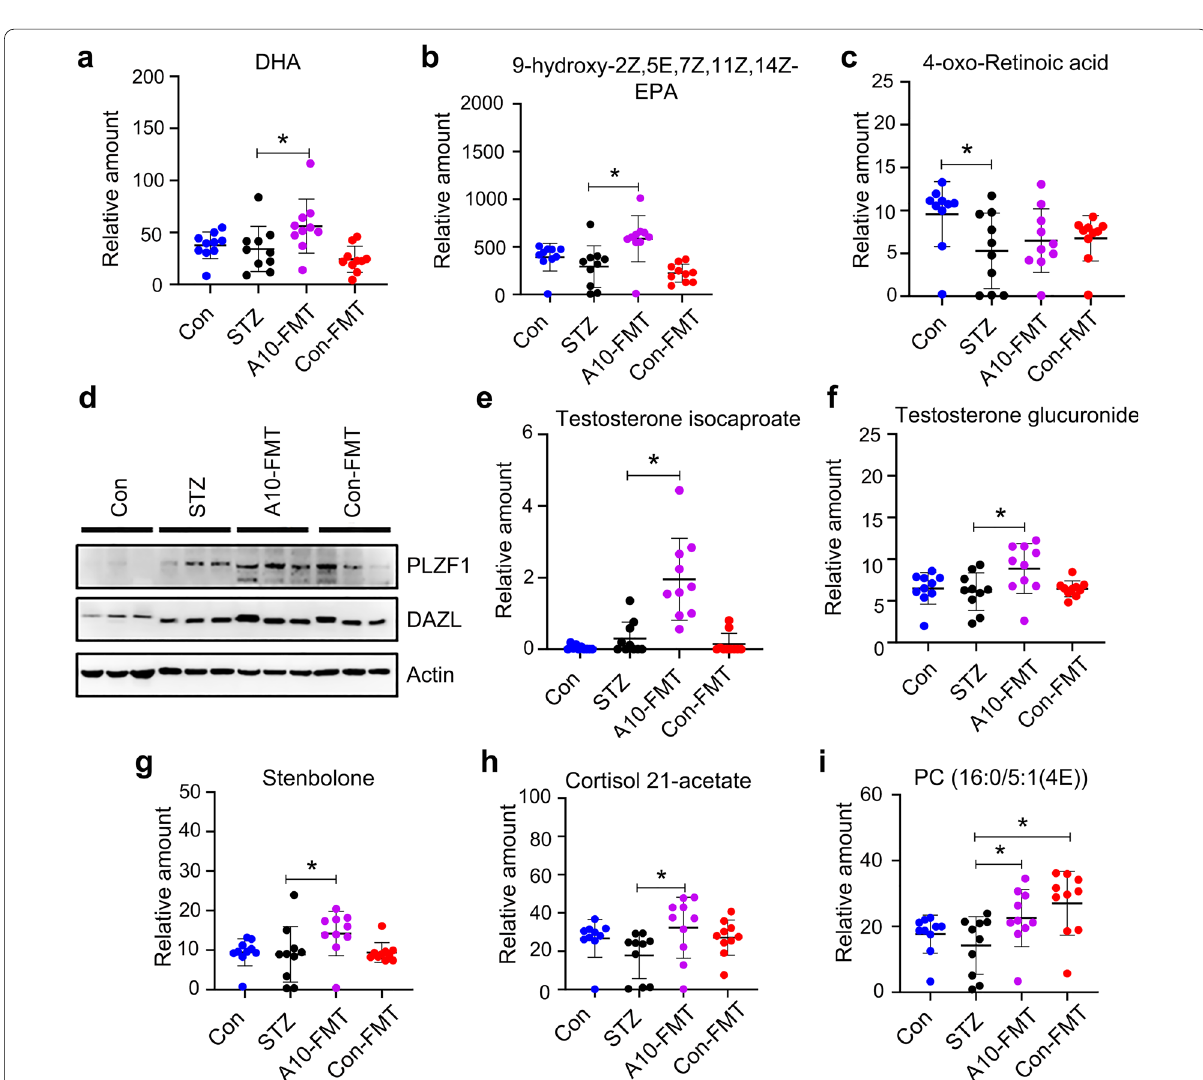
Fig. 4 A10-FMT improved testicular metabolism. a Testicular docosahexaenoic acid (DHA) levels in different treatments. The y-axis represents the relative amount. The x-axis represents the treatment. b Testicular 9-hydroxy-2Z,5E,7Z,11Z,14Z-Eicosapentaenoic acid levels in different treatments. The y-axis represents the relative amount. The x-axis represents the treatment. * p < 0.05. c Testicular 4-oxo-Retinoic acid levels in different treatments. The y-axis represents the relative amount. The x-axis represents the treatment. * p < 0.05. d Testicular protein levels of PLZF and DAZL in different treatments determined by Western blotting. e Testicular testosterone isocaproate levels in different treatments. The y-axis represents the relative amount. The x-axis represents the treatment. * p < 0.05. f Testicular testosterone glucuronide levels in different treatments. The y-axis represents the relative amount. The x-axis represents the treatment. * p < 0.05. g Testicular stenbolone levels in different treatments. The y-axis represents the relative amount. The x-axis represents the treatment. * p < 0.05. h Testicular cortisol 21-acetate levels in different treatments. The y-axis represents the relative amount. The x-axis represents the treatment. * p < 0.05. i Testicular PC (16:0/5:1(4E)) levels in different treatments. The y-axis represents the relative amount. The x-axis represents the treatment. * p < 0.05. n =